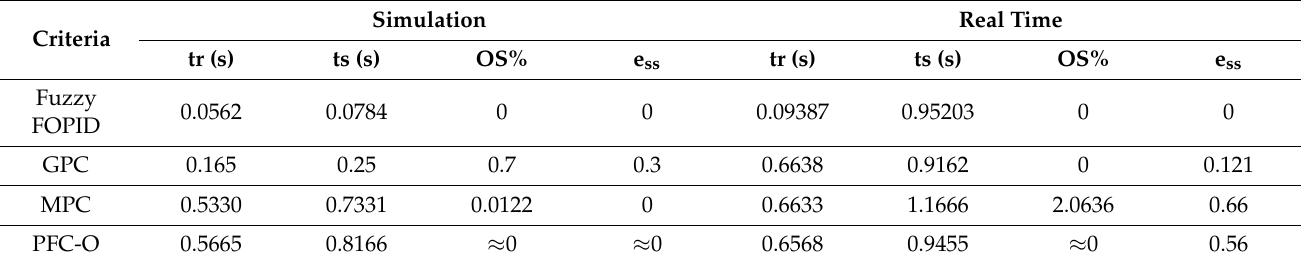
Table 6. Comparison between the fuzzy FOPID and other controllers’